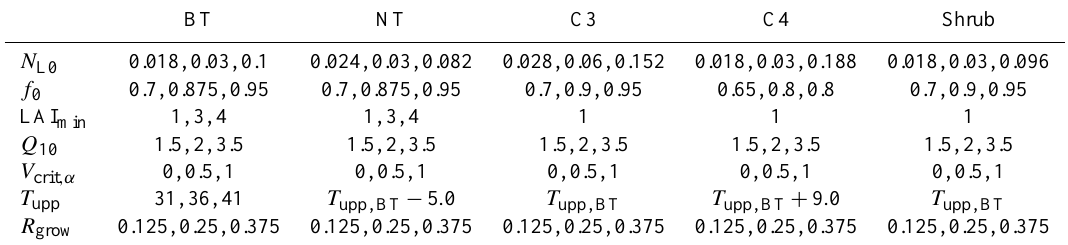
Table 1. List of parameters used in the land surface carbon cycle perturbed physics ensemble. The values of the minimum leaf area index (LAI) for C3, C4 and shrubs are not varied in this work and hence only one value is given. The three different parameters used are (1) the minimum value used in the Latin hypercube sampling scheme (2) the “standard” value used in the simulation framework before parameter perturbation and (3) the maximum value. Note that the ranges used in this work are the same as in Booth et al. (2012). The additional R grow parameter in this work is varied by 50% either side of its standard value. BT NT C3 C4